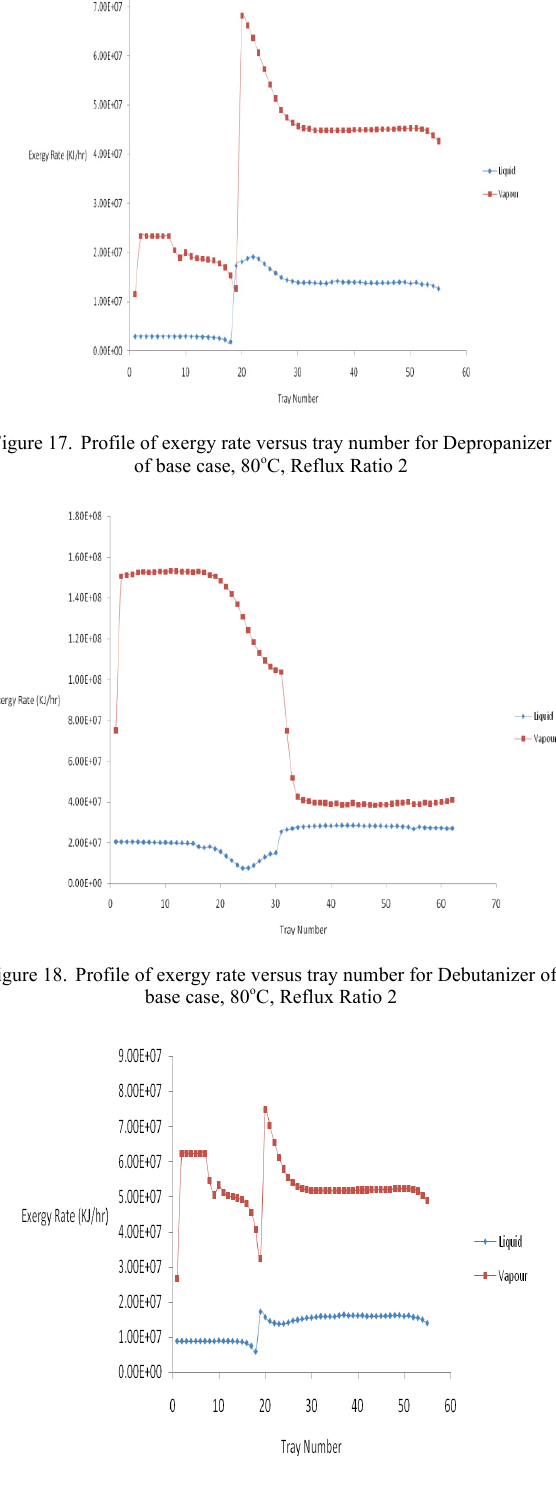
Figure 19. Profile of exergy rate versus tray number for Depropanizer of base case, 80 o C, Reflux Ratio 6